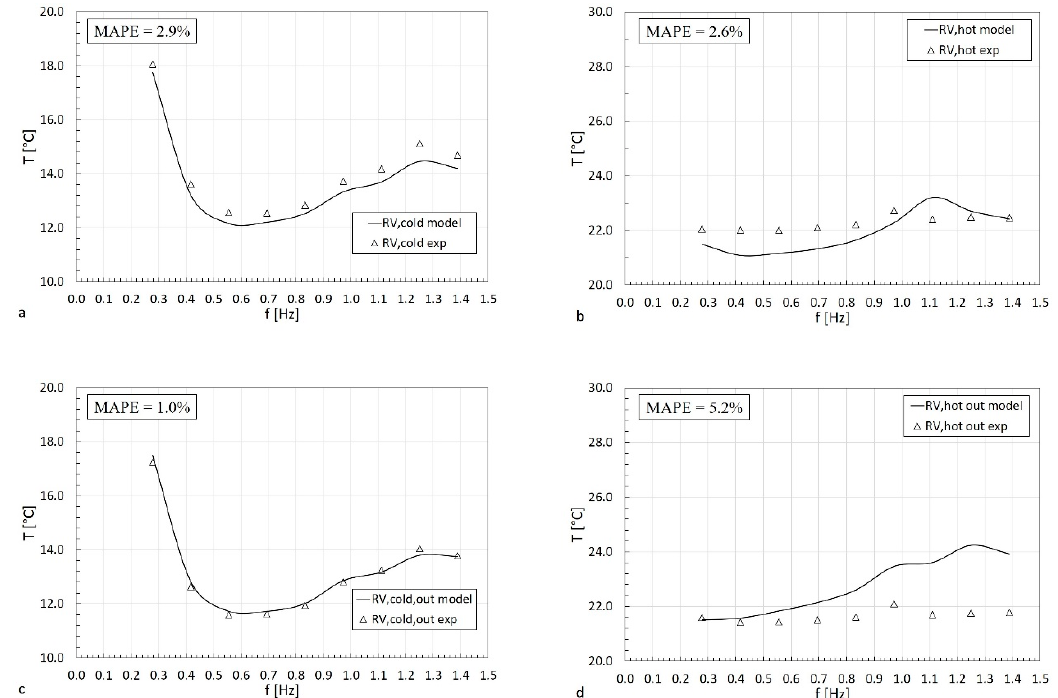
Figure 13. Comparison of experimental measurements and model results of ( a , b ) surface temperatures of both sub-valves ( T RV , C , T RV , H ) and ( c , d ) outlet water temperatures ( T RV , C , out , T RV , H , out ) for T H = 22 ◦ C and di ff erent operating frequency.